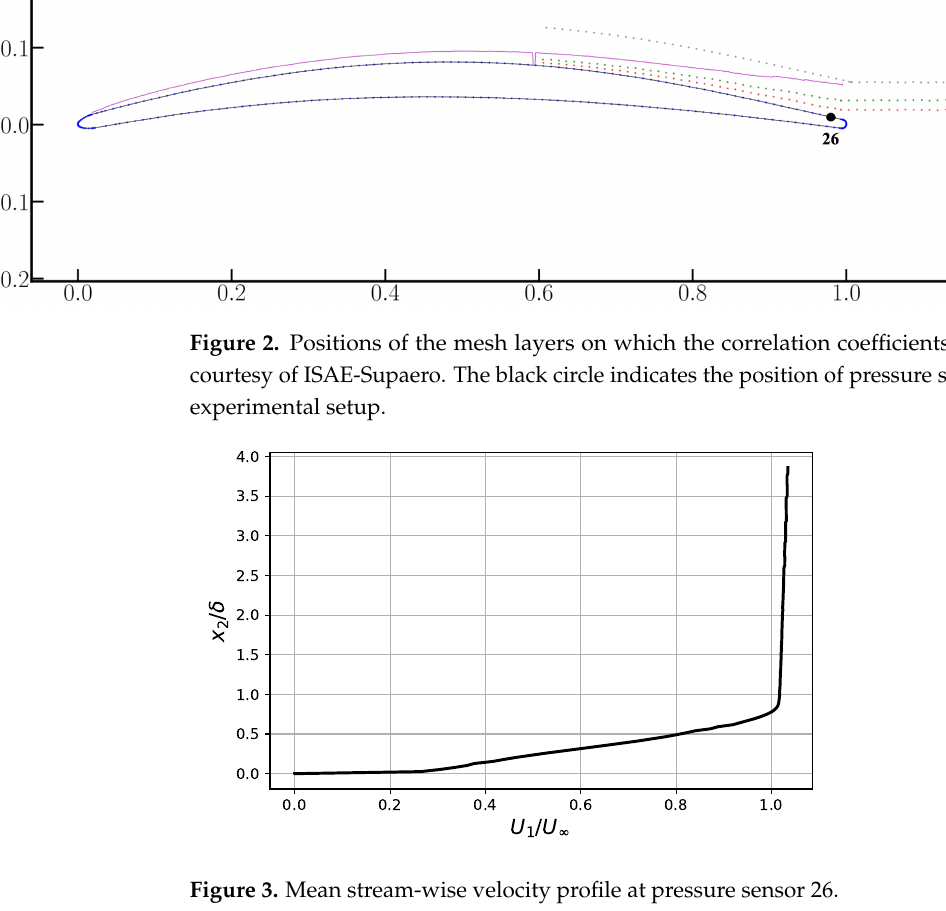
Figure 3. Mean stream-wise velocity profile at pressure sensor 26.